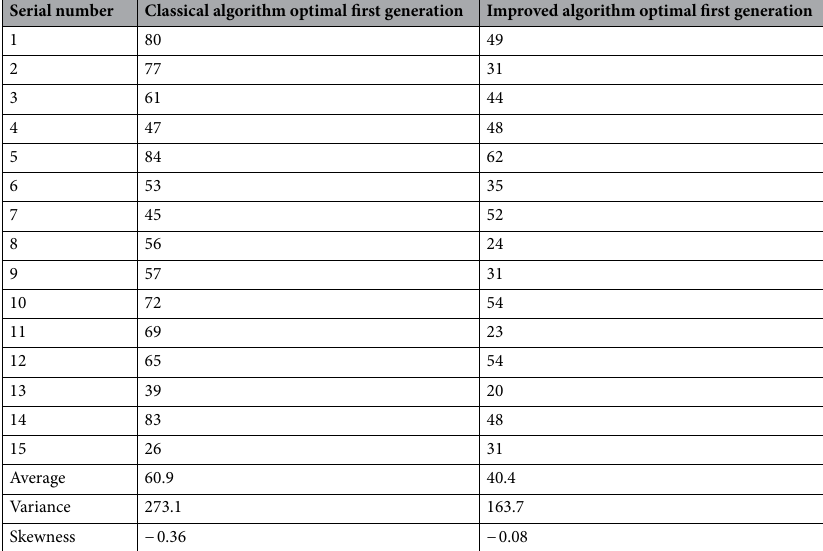
Table 5. Comparison of convergence between classical algorithm optimal first generation and improved algorithm optimal first generation.